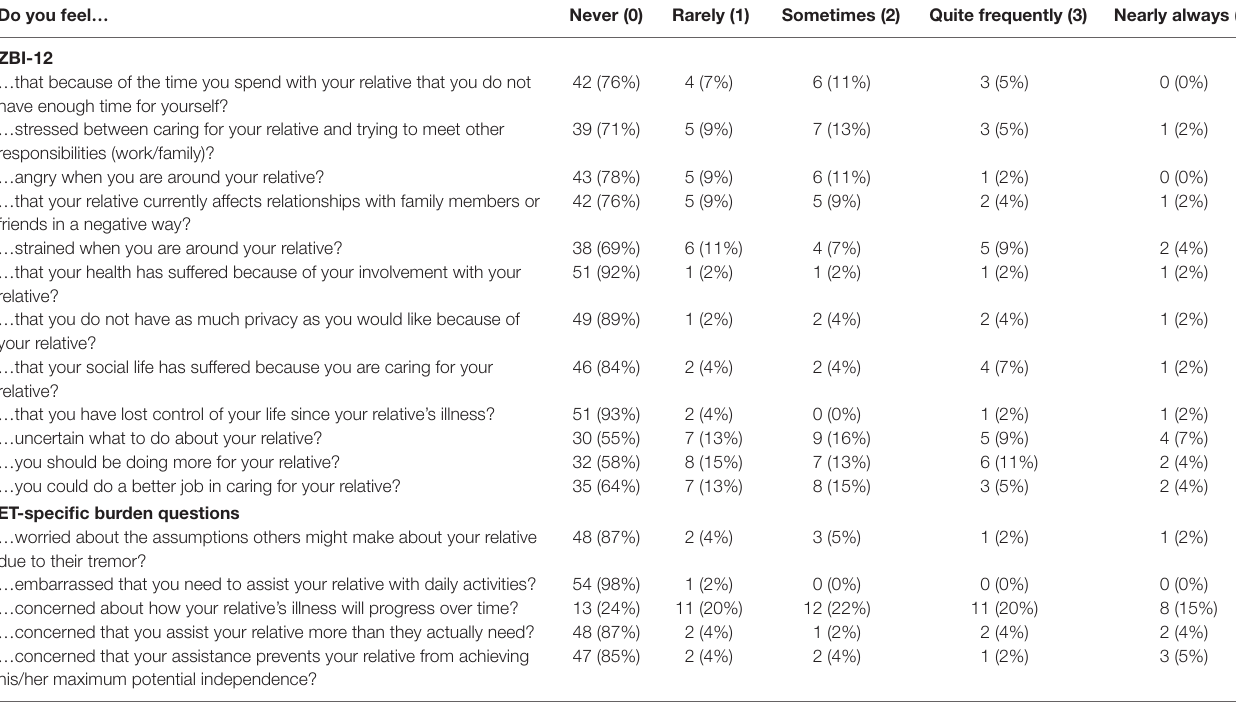
TaBle 3 | Caregivers’ responses to ZBI-12 and to ET-specific burden questions.